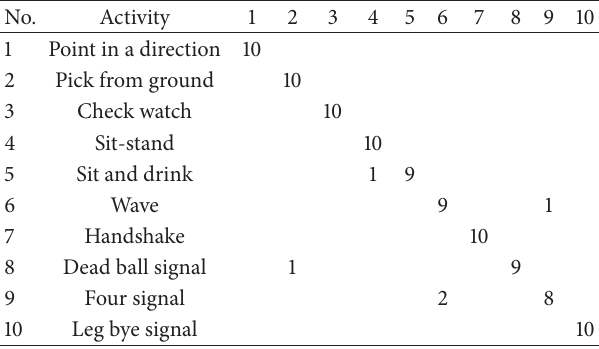
Table 3: Confusion matrix for activity recognition when using manual selection of joints.